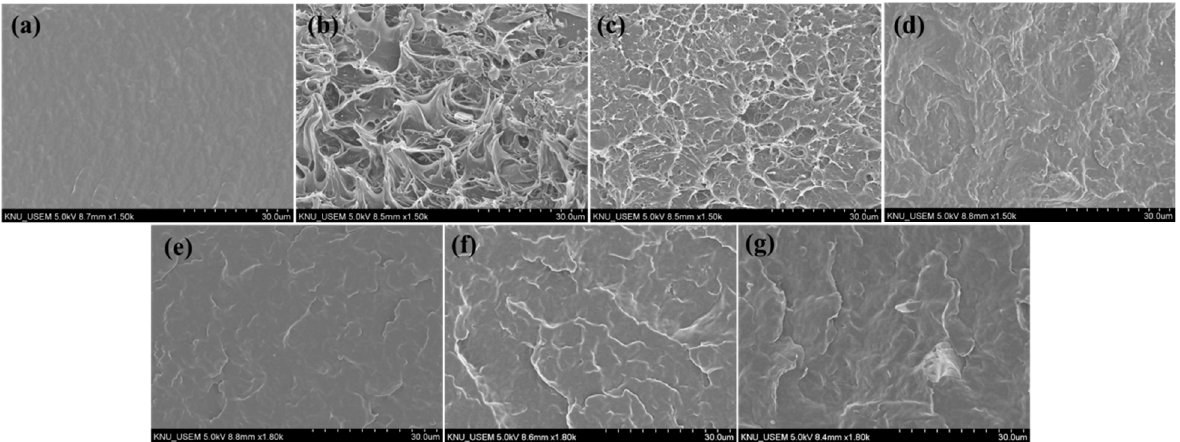
Figure 3. SEM images of the fractured surface of neat PBS ( a ), PBS/PCNF-I (95/5) ( b ), PBS/PCNF-II (95/5) ( c ) PBS/PCNF-II (95/5)PA-1 ( d ), PBS/LCNF5-II (95/5)PA-1 ( e ), PBS/LCNF19-II (95/5)PA-1 ( f ), and PBS/LCNF30-II (95/5)PA-1 ( g ).